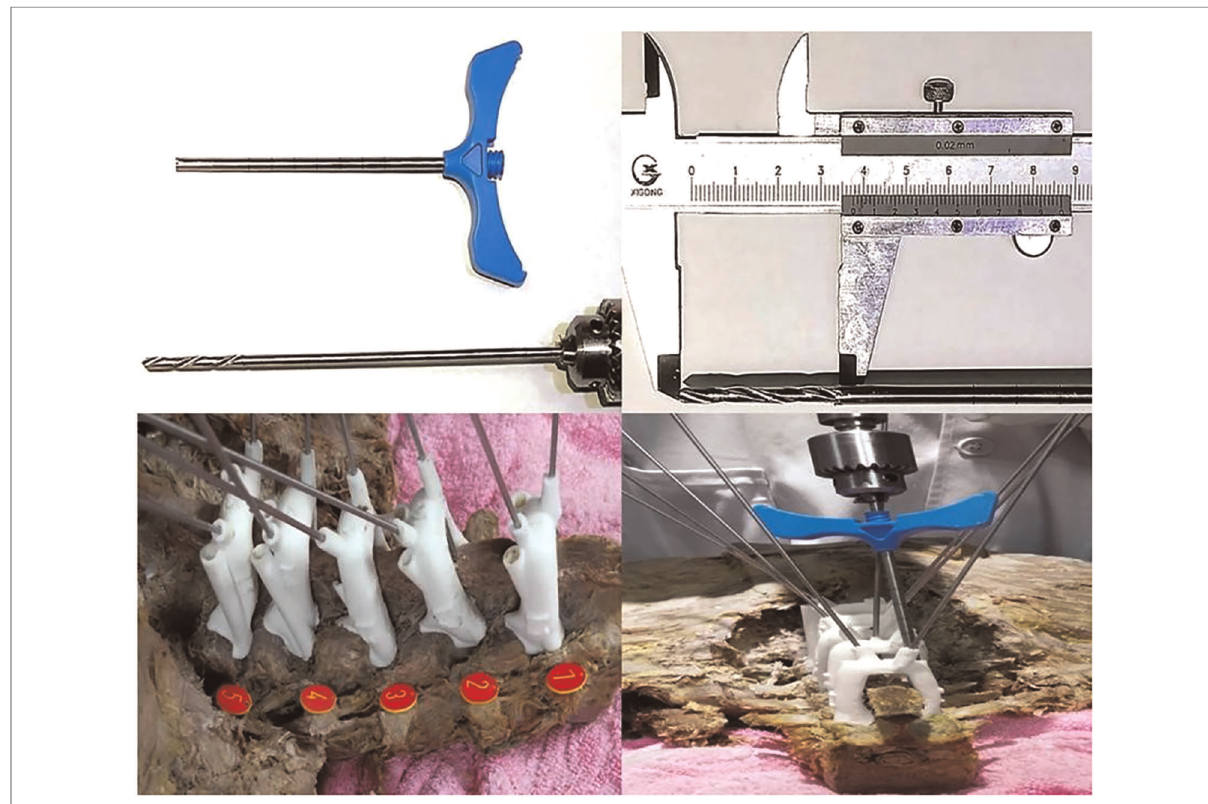
FIGURE 4 Improvement and speci fi c application of inner core structure of the 3D-printed navigation template. We found that the working channel of the spinal balloon expandable bone cement tool can be used well with the cortical bone screw 3D printed navigation template, which increases the strength of the inner wall of the guiding hole, improves the accuracy of screw placement, and avoids breaking the inner wall and a large amount of debris during the drilling